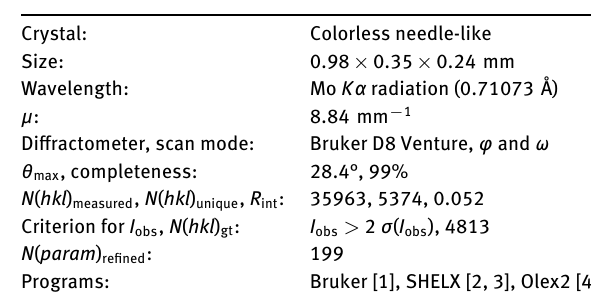
Table 1: Data collection and handling.